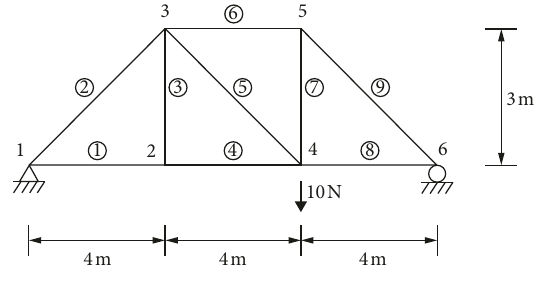
Figure 2: A three-bay truss